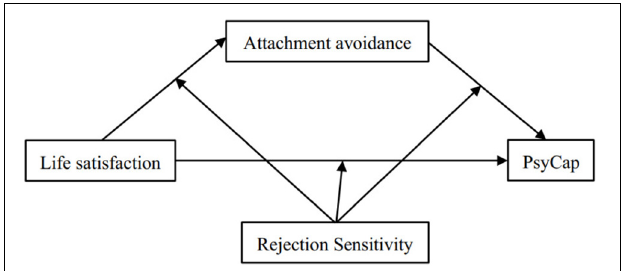
FIGURE 1 | The hypothesis model of this research.